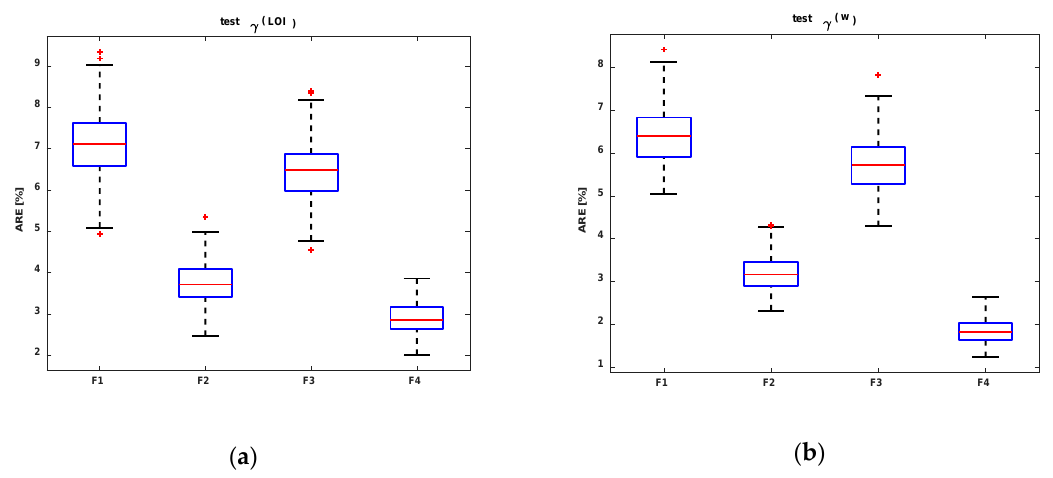
Figure 11. Comparison of the MRE tested models (F1–F4): ( a ) LOI T and ( b ) w . Table 4. The goodness of fit for the regression of the two variables models. Generally, we obtained better results using natural water content. Table 4 presents a comparison of the median of the goodness of fit obtained for the two variables regression models (F5–F8). The best result we obtained was for the F6 regression model.